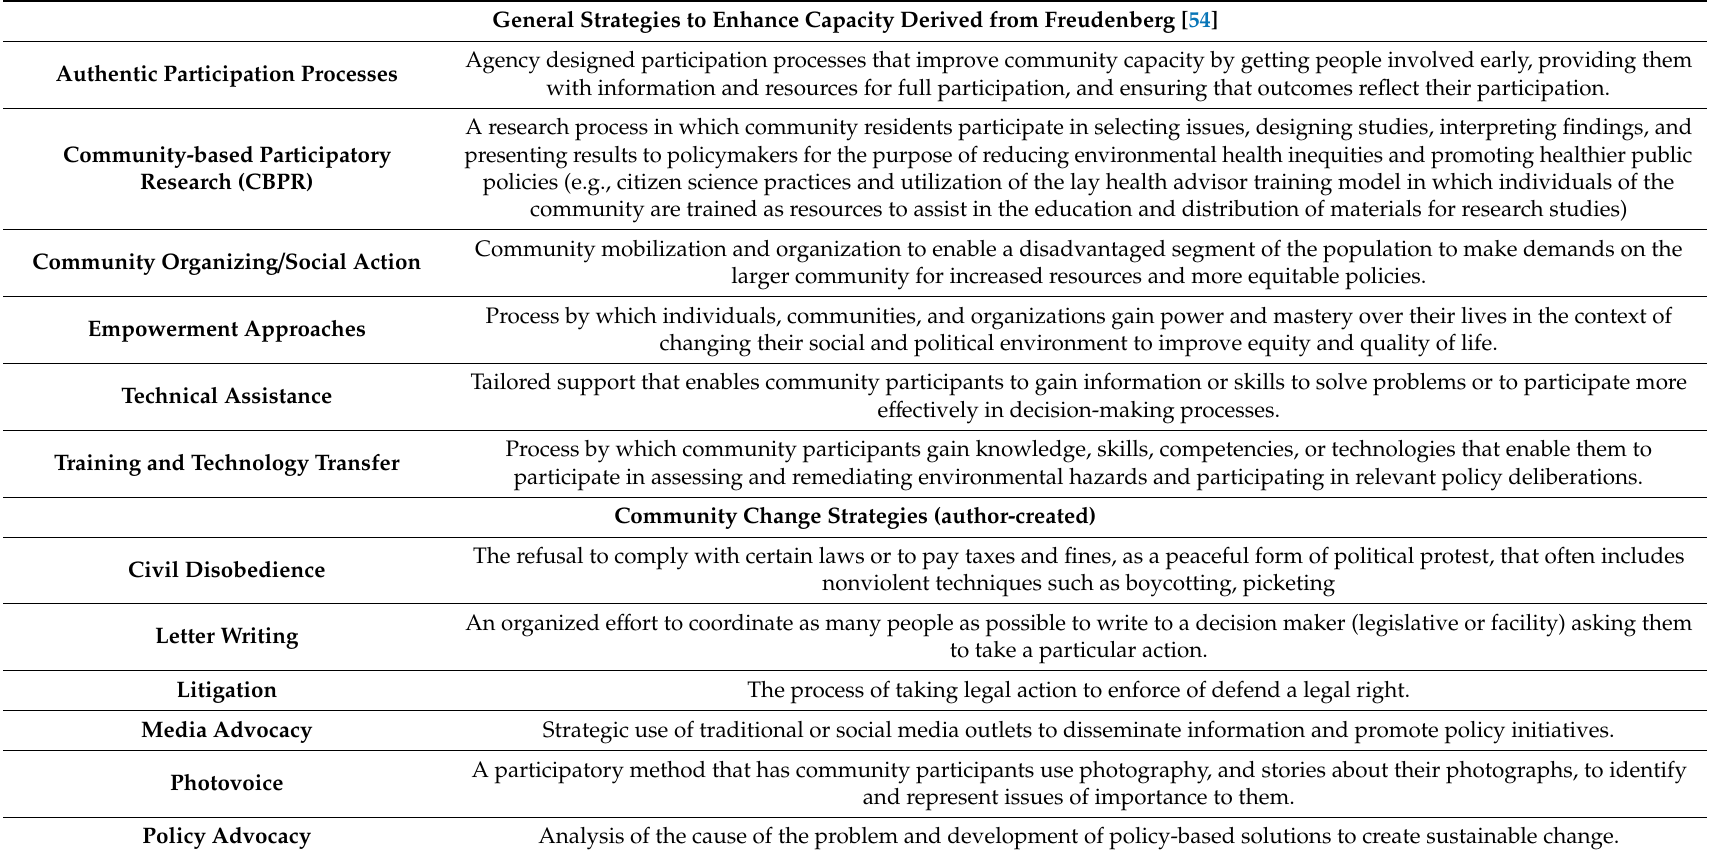
Table 1. Strategies to enhance community